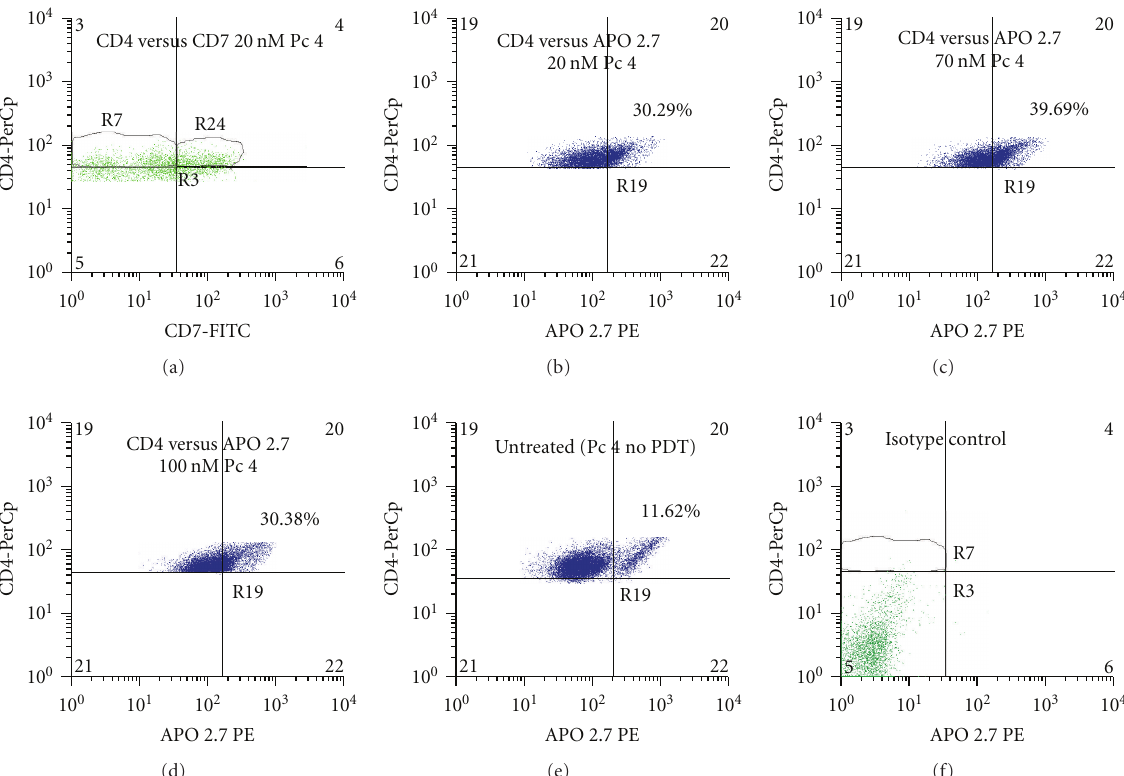
Figure 3: Representative flow cytometric histograms of the induced apoptosis of CD4 + CD7 + lymphocytes treated with Pc 4-PDT. Total blood was obtained from patients diagnosed with Sezary syndrome. The histograms shown were taken from a single patient with SS. PBMCs were isolated, treated with Pc 4, and stained as mentioned previously in the Methods section. Lymphocytes were identified by their high CD4 expression ( y -axis) and forward scatter ( x -axis) as described previously. CD4 + CD7 + lymphocytes were further identified in region R24 in (a). Levels of apoptosis induced by all three doses in this population were then analyzed. As shown in (b), (c), and (d), these levels remained relatively similar and P -values were largely insignificant from group to group. Apoptosis induction in the untreated group is shown in